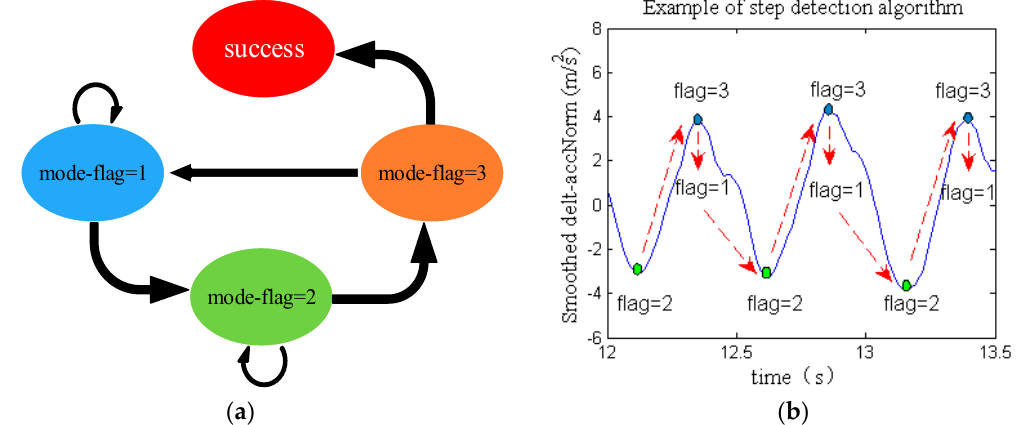
Figure 4. ( a ) Flowchart of step detection. ( b ) Example of step detection algorithm.